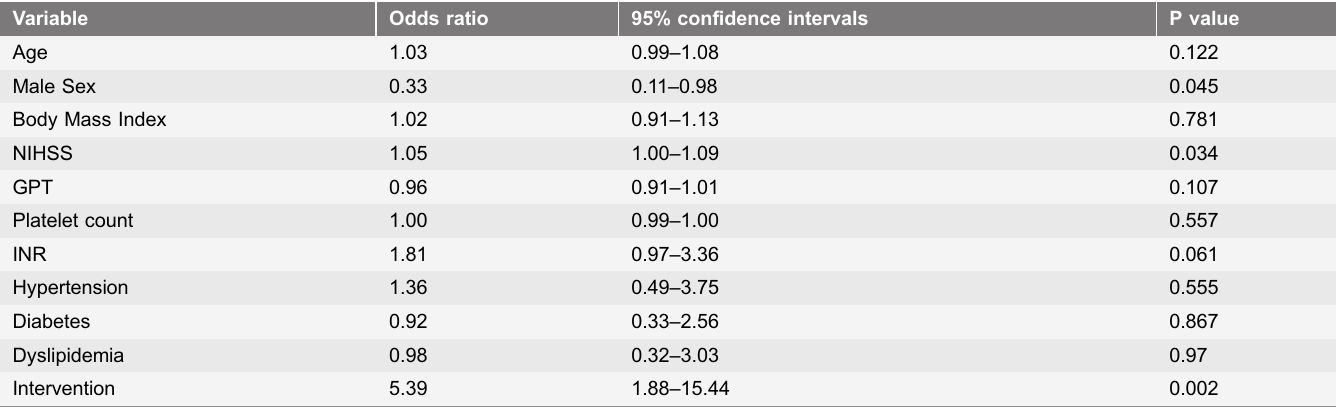
Table 2. Predictors of ultrasound diagnosis of deep vein thrombosis: logistic regression